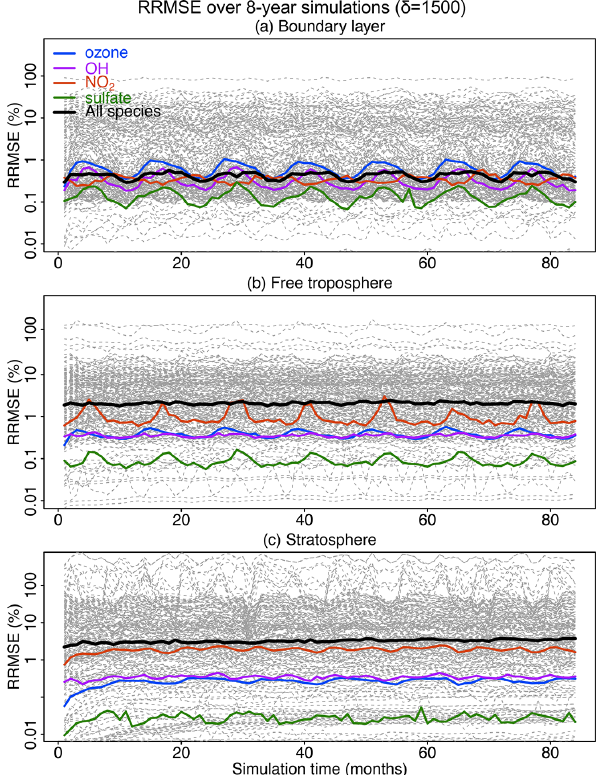
Figure 7. Accuracy of the adaptive reduced chemistry mechanism algorithm over an 8-year GEOS-Chem simulation using a threshold δ of 1500 moleculescm − 3 s − 1 to separate fast and slow species. We show the RRMSE in the (a) boundary layer, (b) free tropo- sphere, and (c) stratosphere. Results are also shown for the median RRMSE across all species in the mechanism and more specifically the RRMSE for ozone, OH, NO 2 , and